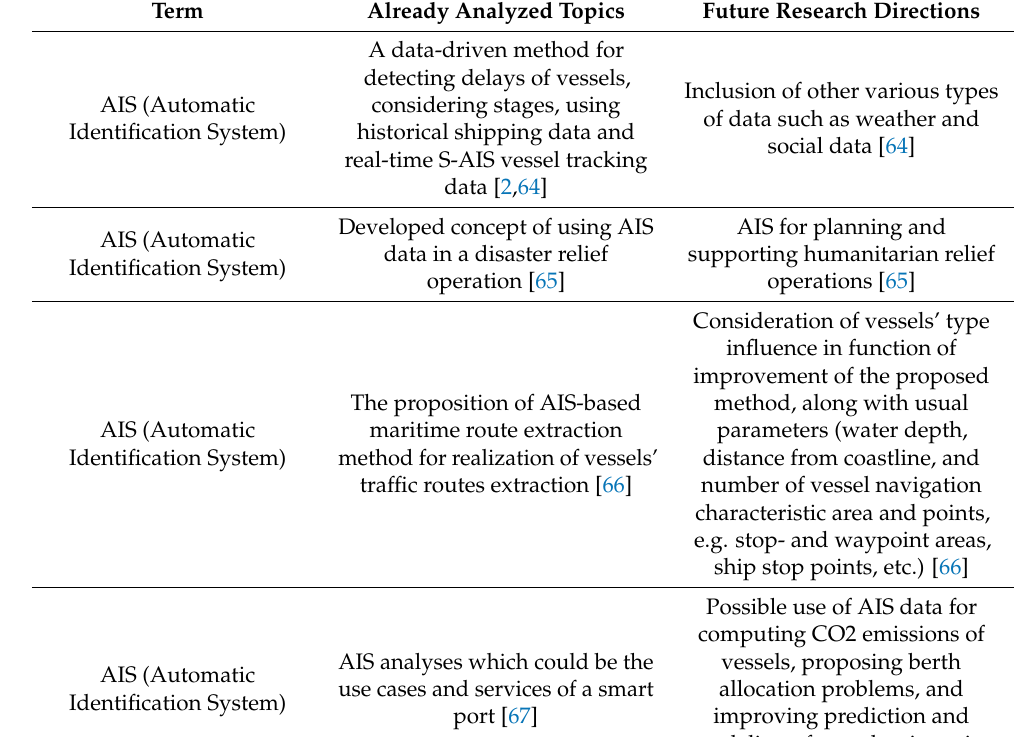
Table 11. Future research